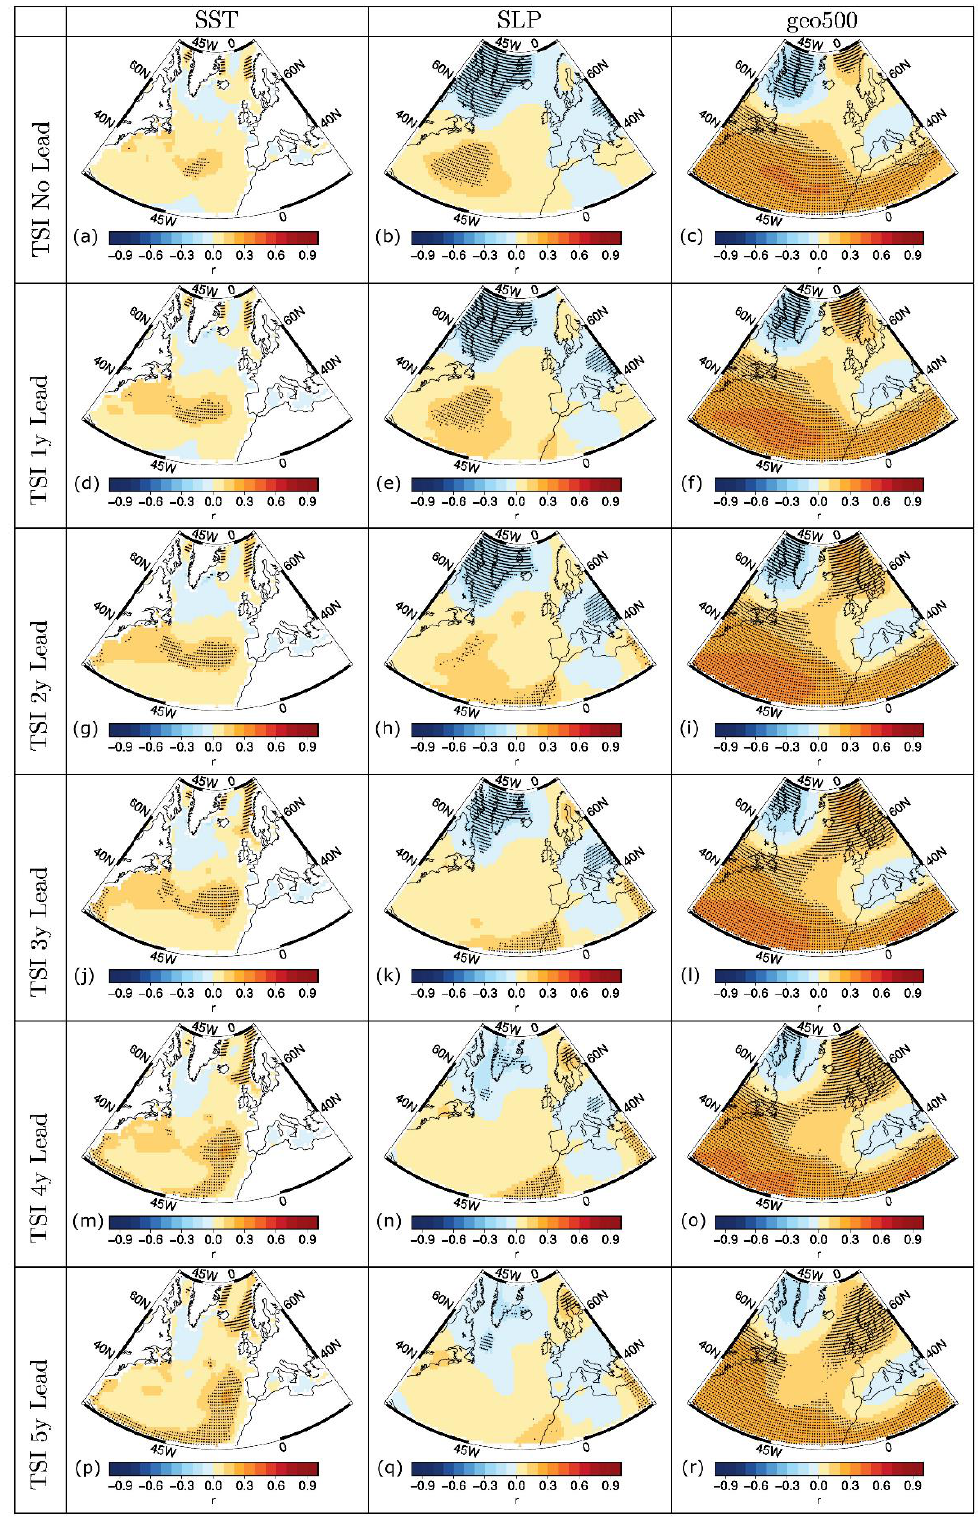
Figure 5. Correlation patterns between TSI and the SST ( a , d , g , j , m , p ), the SLP ( b , e , h , k , n , q ) and the geo500 ( c , f , i , l , o , r ) for the CESM ensemble mean. The correlation is given in the first row for no lead-time. As the row number increases, the TSI lead time increases by one year. The hatched areas indicate statistical significance at the 5% level. The range of r-values for SSTs, SLP and geo500 is approximately ±0.3, ±0.2, and ±0.4, respectively.